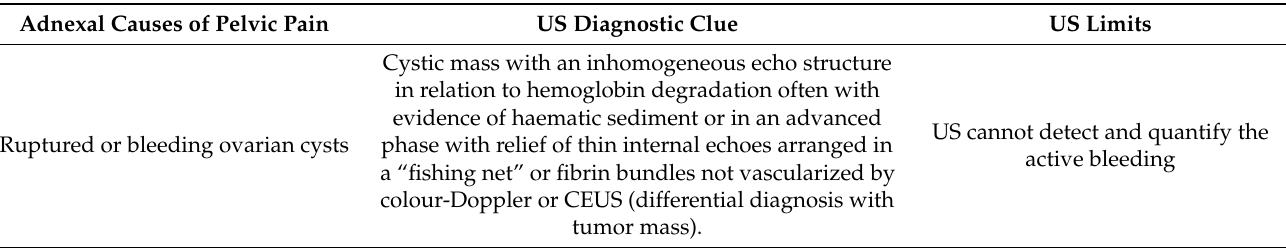
Table 4. Ruptured or bleeding ovarian cysts US diagnostic